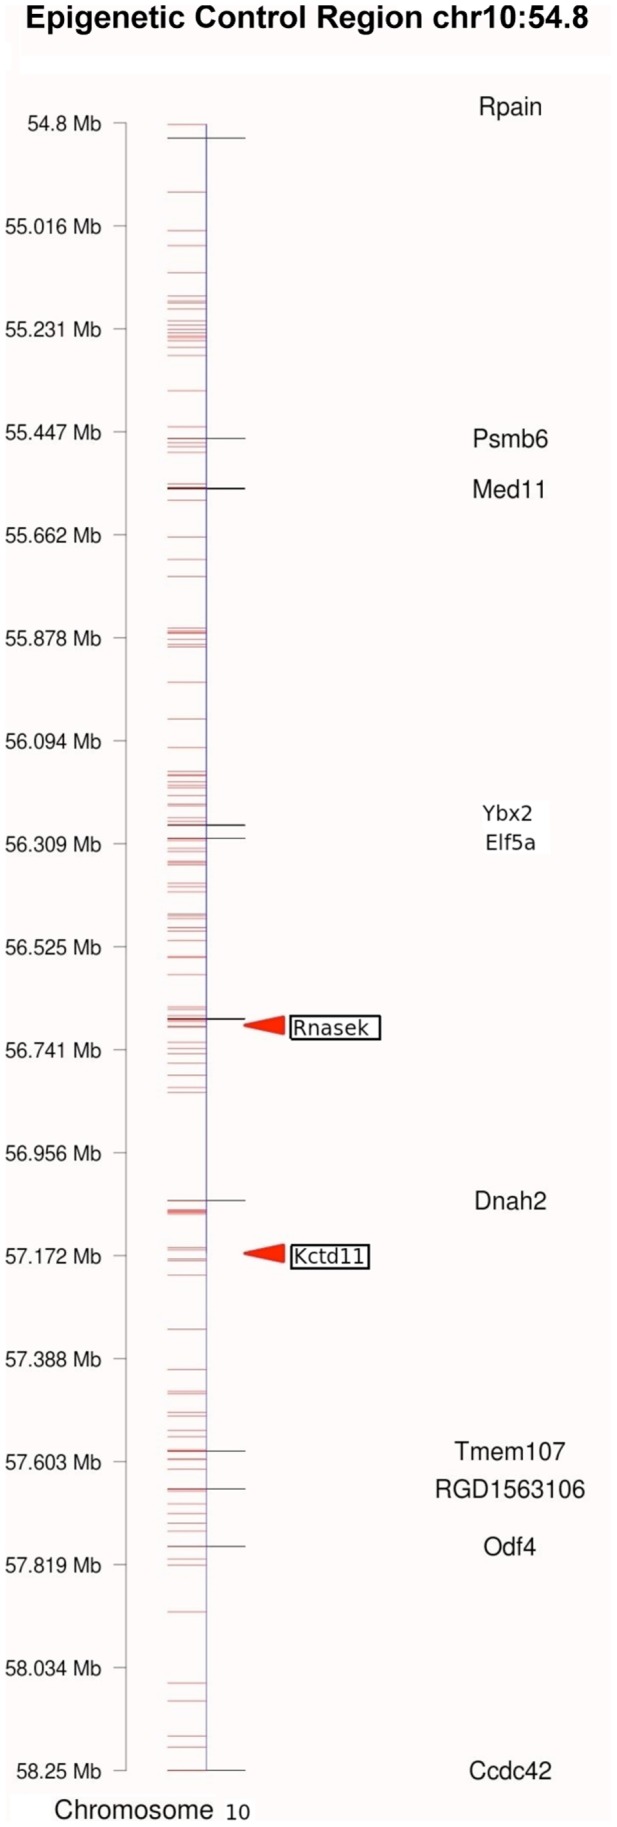
Example of an epigenetic control region (ECR) on chromosome 10.The chromosomal location in megabases is presented with all genes (horizontal lines) and regulated genes (gene symbols) listed. The DMR are listed in arrow heads.